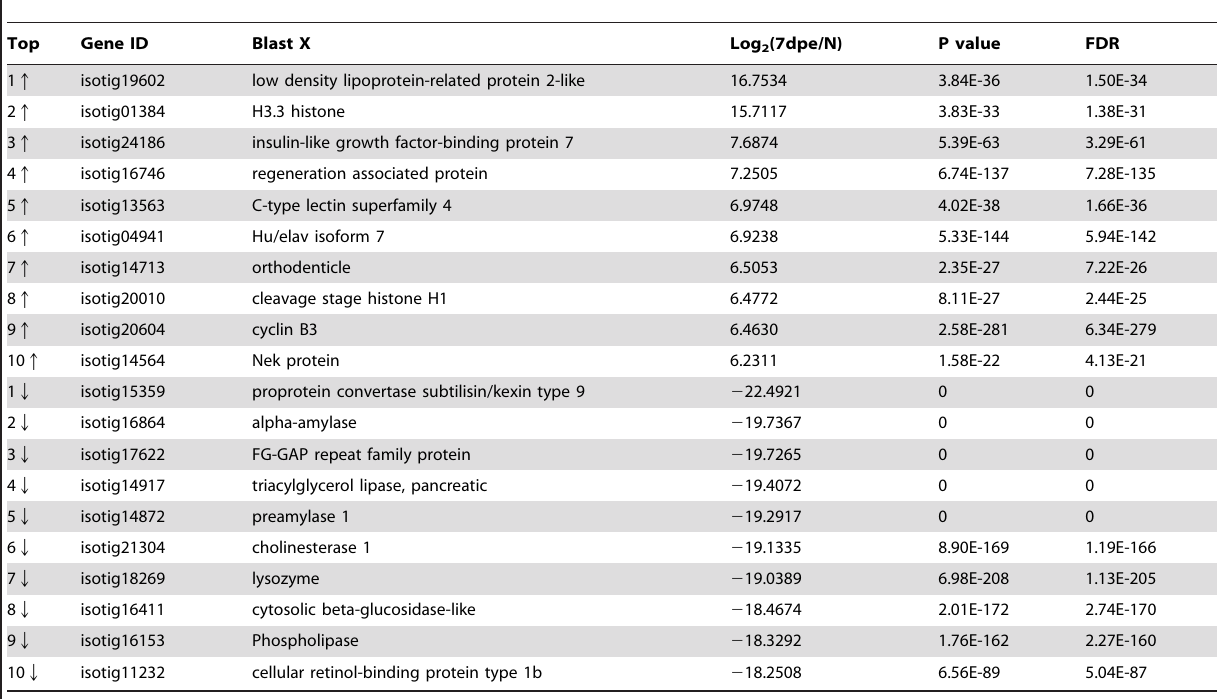
Table 3. Top 10 differentially expressed genes at 7 dpe VS